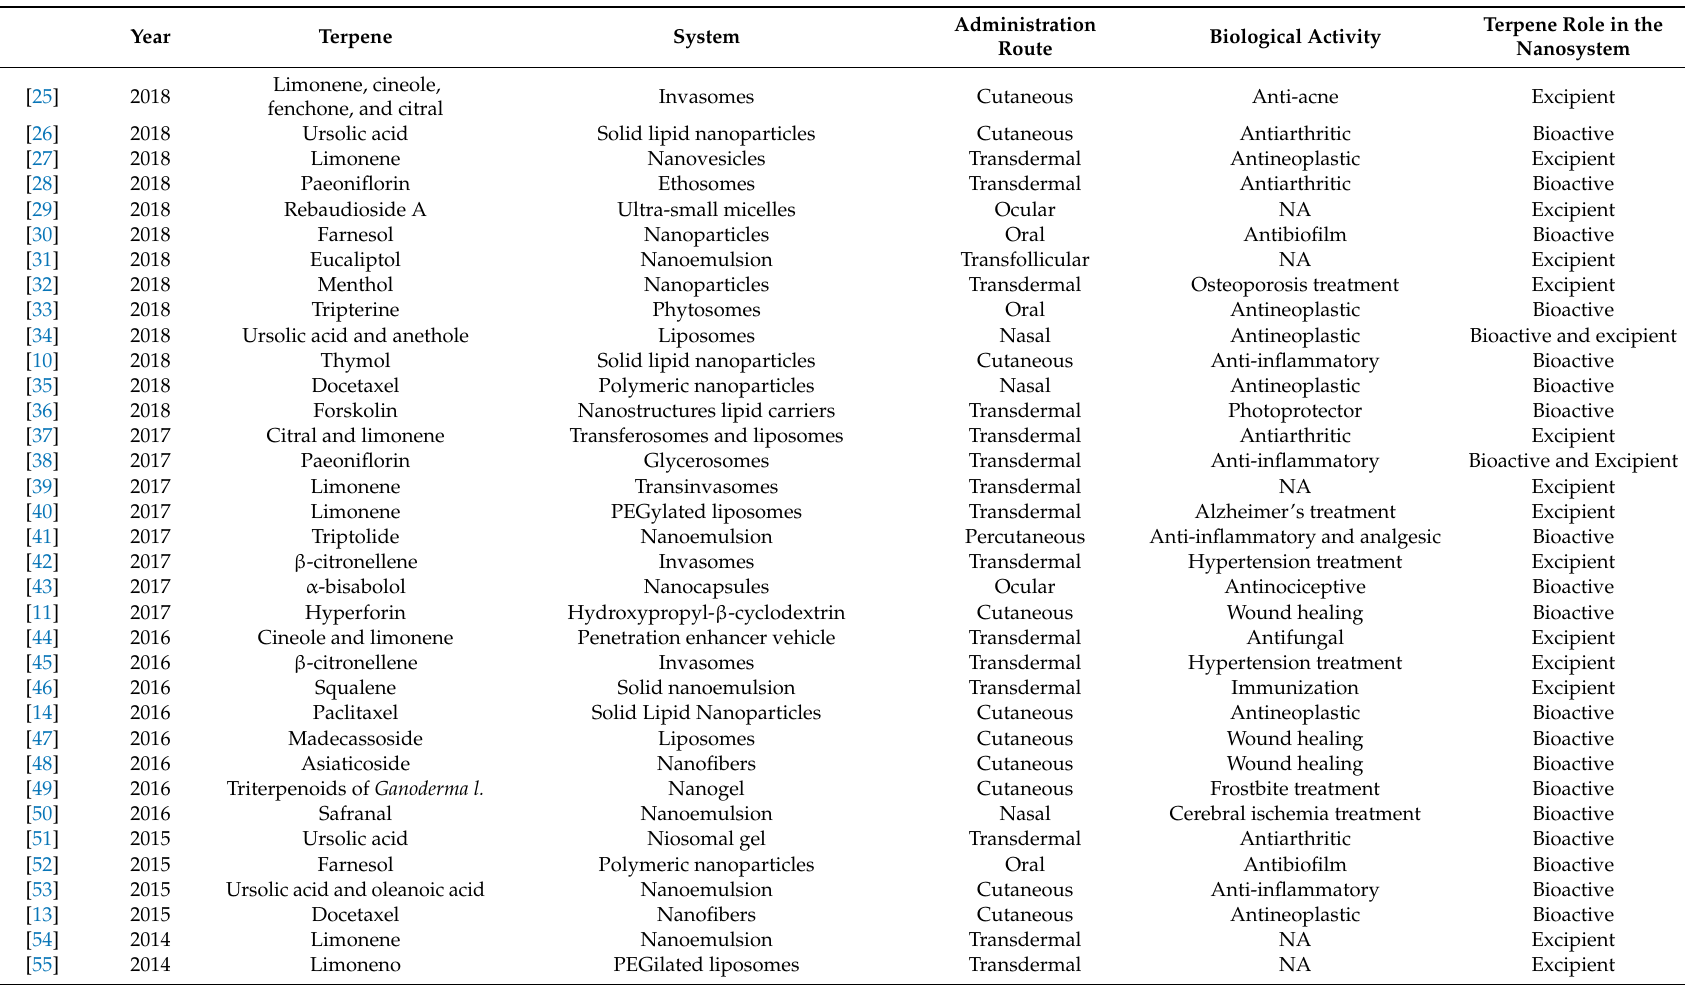
Table 1. Publications found in the literature concerning the encapsulation of isolated terpenes in nanostructured systems intended for topical